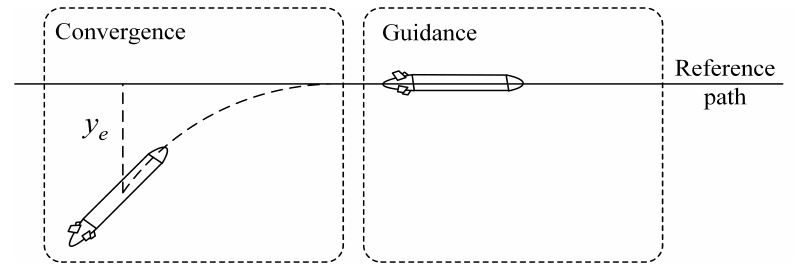
Figure 5. Convergence stage and guidance stage of path following.